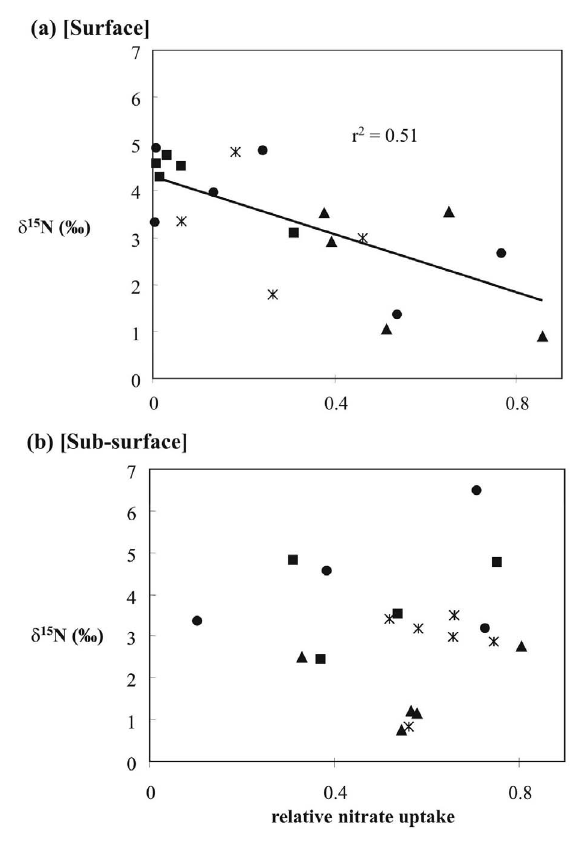
Fig . 6. – Relationship between the nitrate relative to nitrate plus ammonium uptake rate and the d 15 N of particulate organic nitrogen ( d 15 N-PON) for surface (a) and sub-surface chl a fluorescence maxi- mum (b) samples in summer (circles), autumn (squares), winter (triangles) and spring